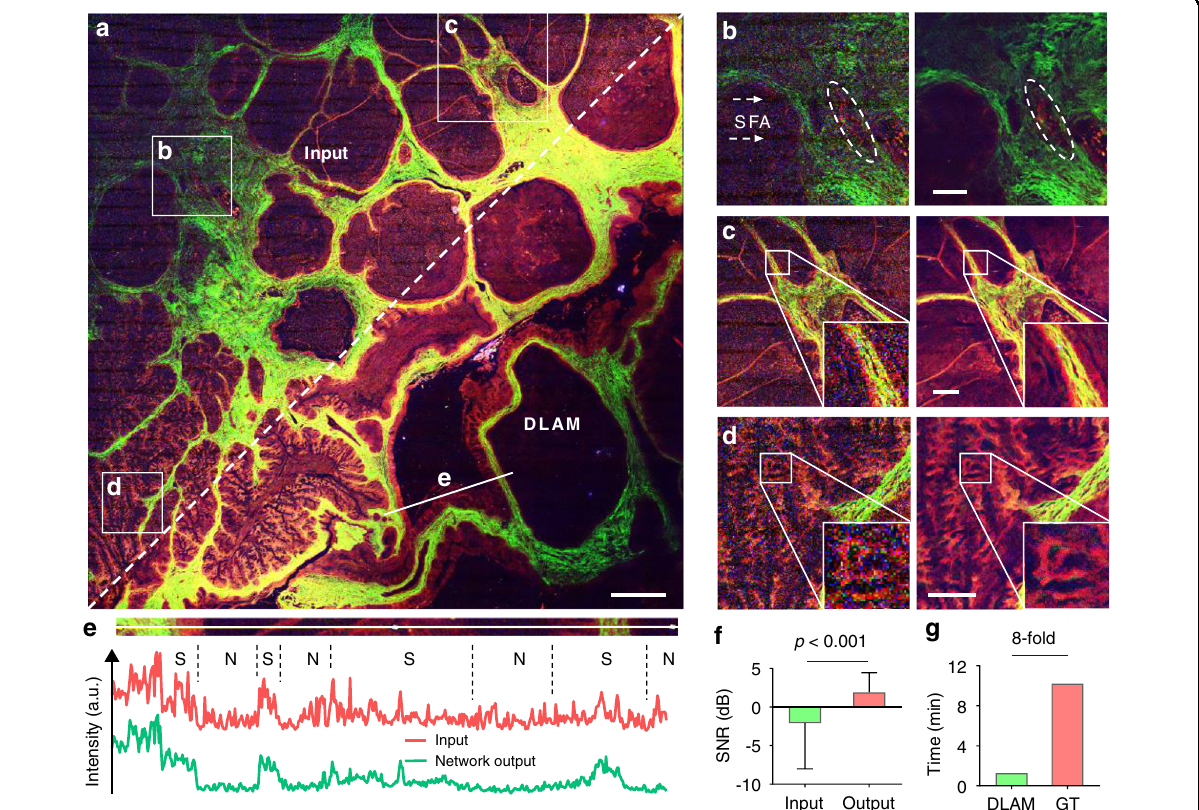
Fig. 2 Deep learning-enhanced auto fl uorescence-harmonic imaging. a A 5.4 × 5.4 mm 2 area image of human ovarian borderline carcinoma